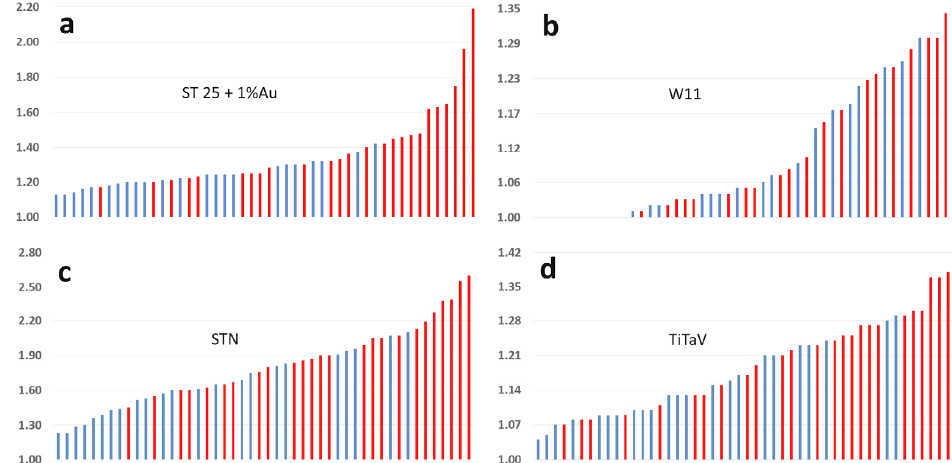
Figure 4. One sensor approach. Responses of the four sensors, sorted by their amplitude and plotted in ascending order. Blue and red bars are the sensor responses to healthy subject blood samples and tumor ones, respectively. ( a ), ST25 sensor; ( b ), W11; ( c ), STN; ( d ), TiTaV.